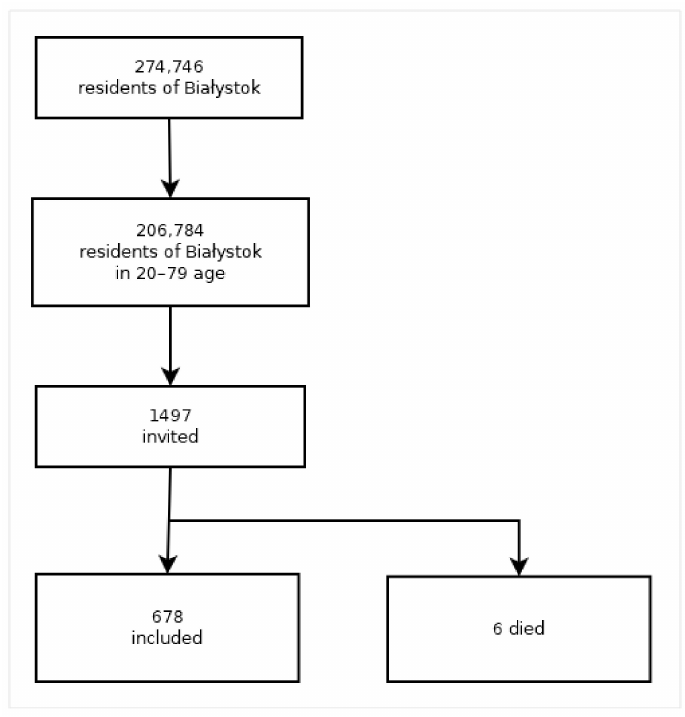
Figure 1. Analyzed